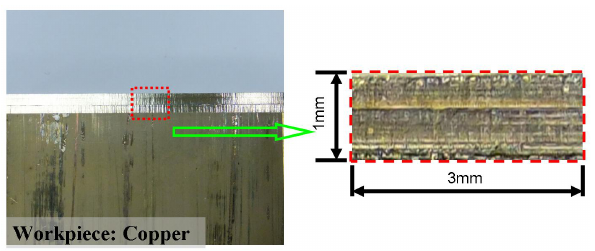
Figure 21. Micrograph of finished workpiece (aluminum).